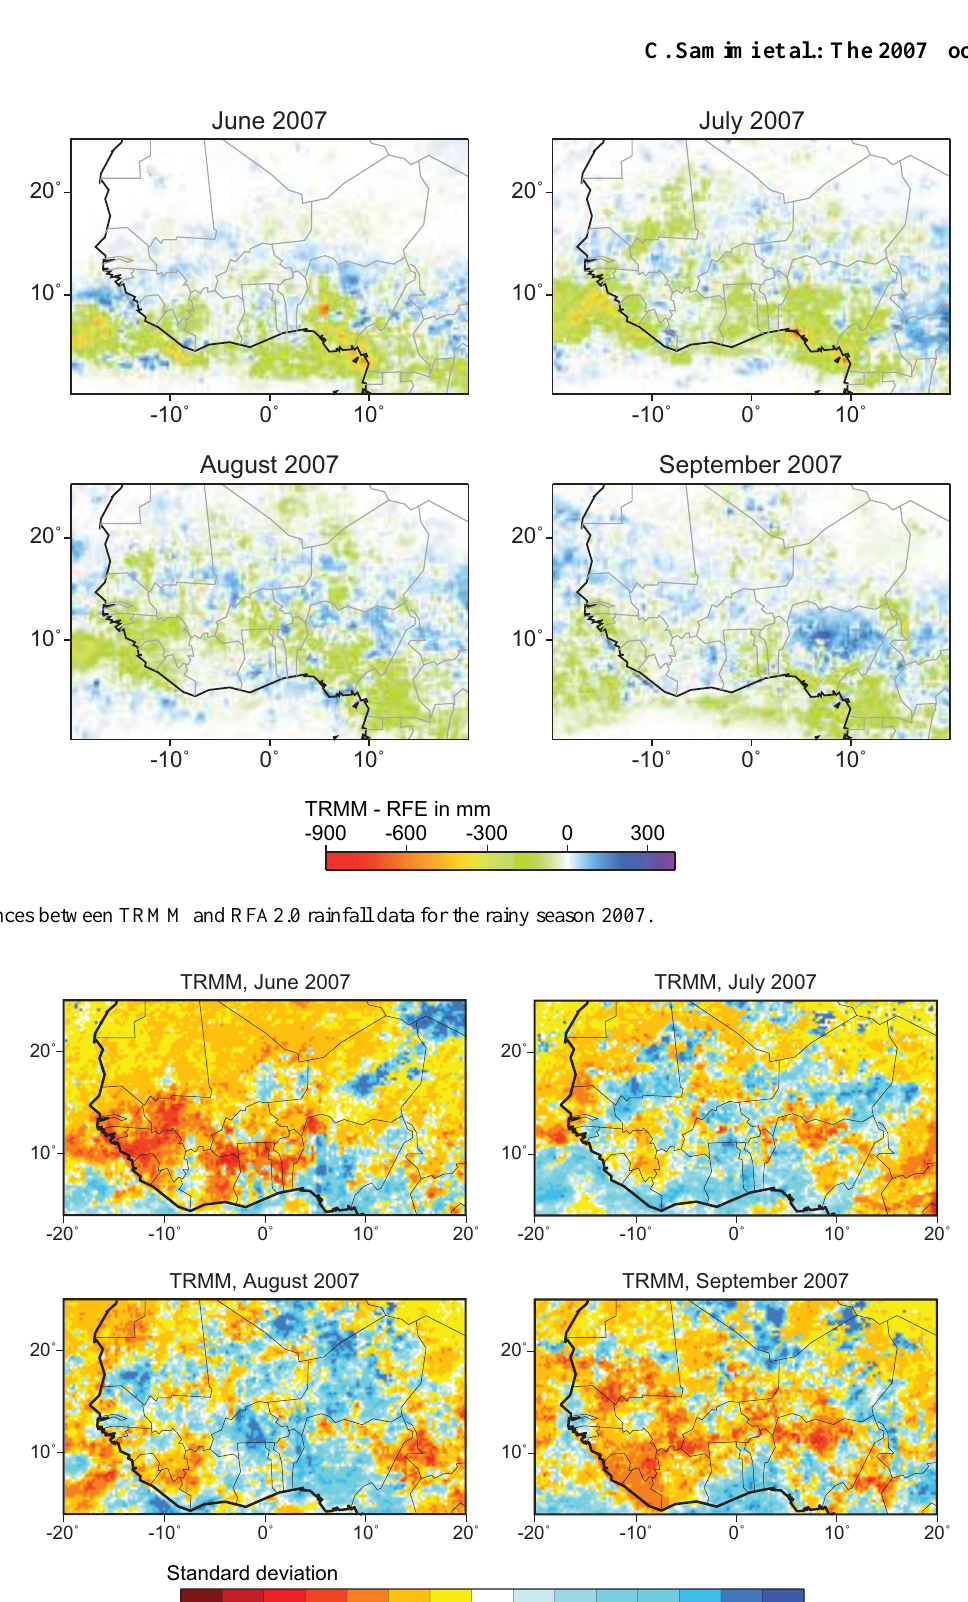
Nat. Hazards Earth Syst. Sci., 12, 313–325,